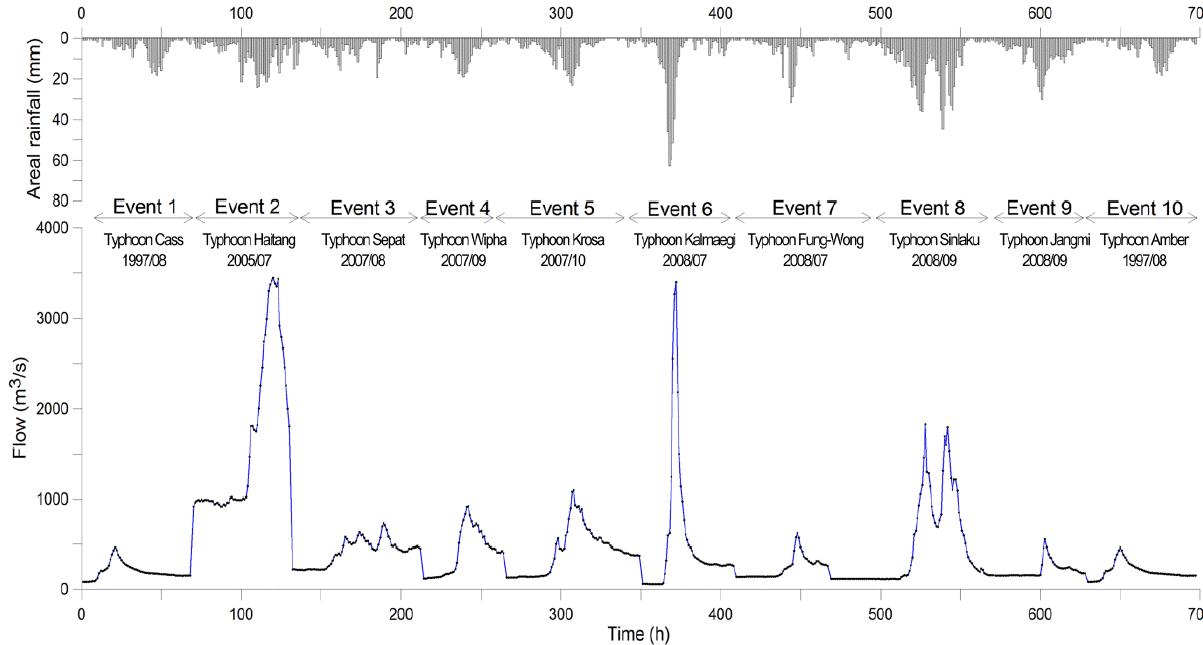
Figure 4. The areal rainfall and flow data used in this